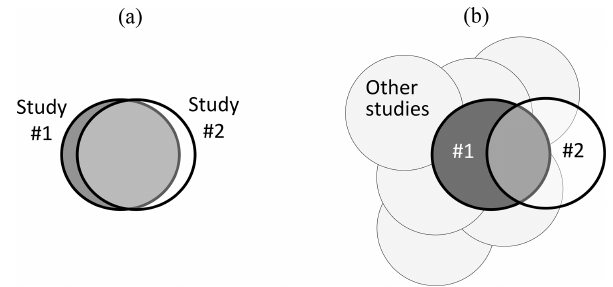
Figure 1. Visual summary of contrasting situations relating to (a) very close matching and (b) part-matching of pairs of studies where Study no. 2 is intended to provide a test of repeatability (and generalizability) of Study no. 1. Whilst “other studies” are also rel- evant to situation (a) , their importance is increased when interpret- ing results from situation (b) . See text for more detailed explanation and discussion, including the importance of experimental co-design between research groups with contradictory